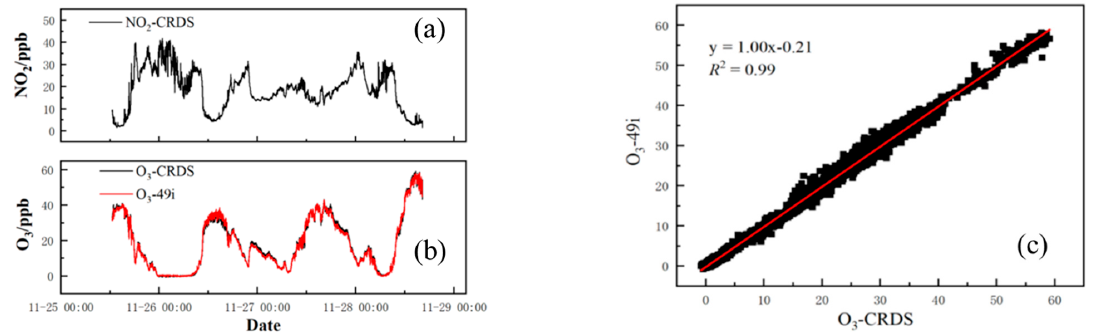
Figure 8. ( a ) NO 2 mixing ratios via CRDS (1 min average). ( b ) O 3 mixing ratios via CRDS and 49i (1 min average). ( c ) Scatter plots for the O 3 dataset from CRDS and the 49i ozone analyzer. The red lines illustrate the linear regression. 4. Conclusions A cavity ring-down spectrometer with adequate selectivity and sensitivity for in situ simultaneous measurements of O 3 and NO 2 in the troposphere was developed. It offers accuracy comparable to commercial UV absorption instruments, but with substantially improved sensitivity and time response. The instrument described here demonstrates an accuracy of 6%, detection sensitivity of 14.5 pptv in ambient air after absorption by the activated carbon adsorbent and MnO 2 adsorbent, and a 10 s time resolution. The O 3 /NO 2 -CRDS instrument was compared in the laboratory and in the field with an 49i ozone analyzer under a variety of sampling conditions. The O 3 /NO 2 - CRDS and 49i O 3 measurements were highly correlated over wide concentration ranges of O 3 and were within the combined stated measurement uncertainties. The combination of simultaneous NO 2 and O 3 measurements offers additional advantages in convenience and accuracy over existing instruments. Commercial UV absorbance instruments do not offer NO 2 measurements. Thus, this instrument represents a simple, robust, and potentially low- cost method for these two related measurements. Author Contributions Conceptualization, X.L., Y.C. and R.H.; methodology, X.L. and R.H.; formal analysis, X.L. and R.H.; investigation, X.L., H.T., H.X. and Z.H.; resources, R.H.; writing—original draft preparation, X.L.; writing— review and editing, Y.C. and R.H.; All authors have read and agreed to the published version of the manuscript. Funding This research was funded by the National Natural Science Foundation of China (61905003, 62275250), the Natural Science Foundation of Anhui Province (No. 2008085J20), the Anhui Provincial Key R&D Program (2022l07020022) and the National Key R&D Program of China (2017YFC0209401).